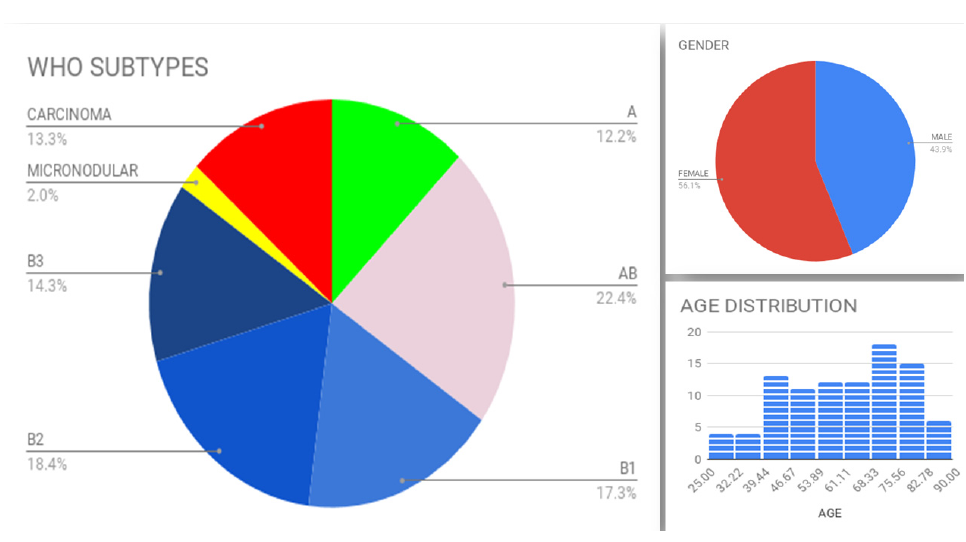
Figure 1. Distribution of WHO subtypes, gender and age.